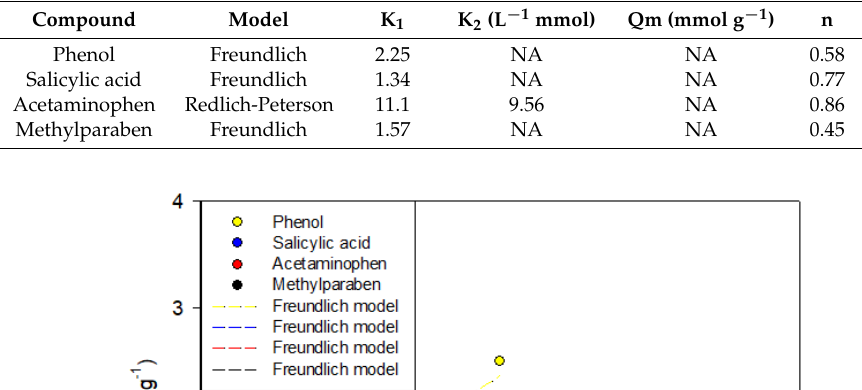
Figure 4. Adsorption isotherm of phenol, acetaminophen, salicylic acid, and methylparaben on activated carbon CAG at 293 K. Table 9. Parameters of Freundlich and Redlich-Peterson models for phenol, acetaminophen, salicylic acid, and methylparaben adsorption on activated carbon CAG.